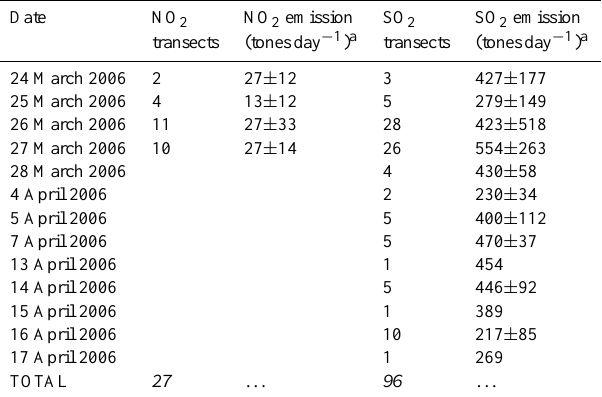
Table 1. Summary of measurements at Tula industrial complex. Table 2. SO 2 and NO x emission inventories and NO 2 measure- ments of Tula industrial